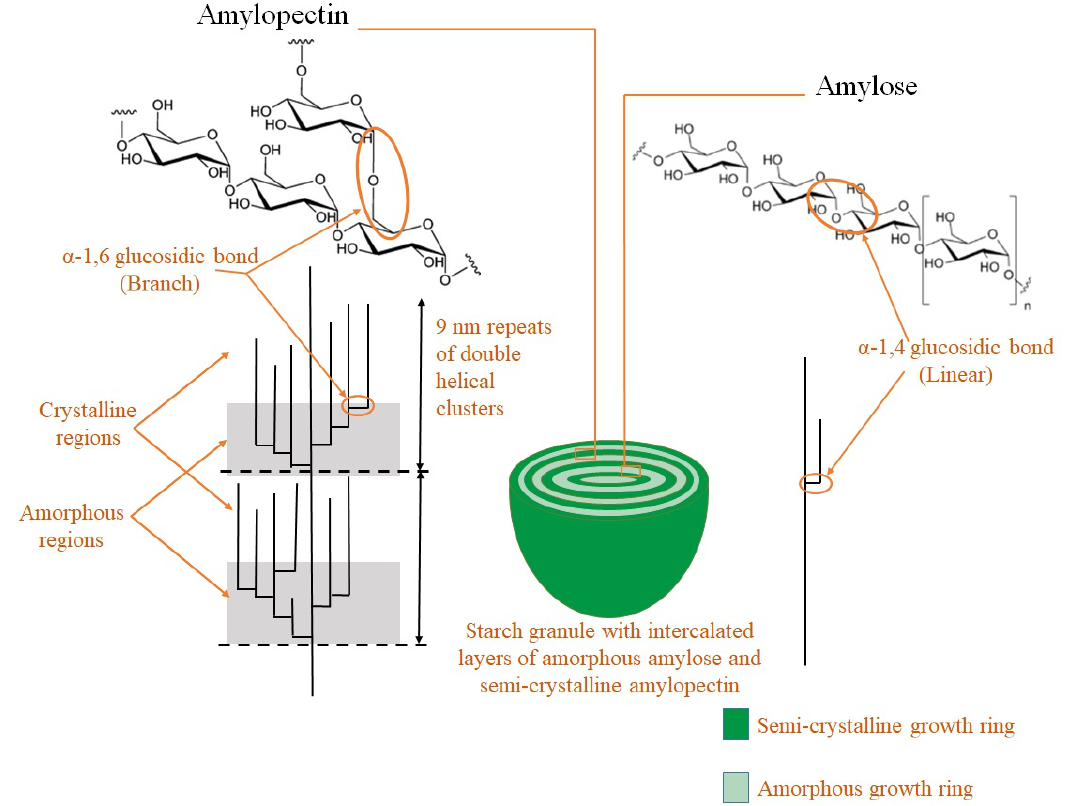
Figure 2. Schematic representation of a starch granule with its structure and types (redrawn from O’Neill and Field [11] and Raguin and Ebenhöh, 2017